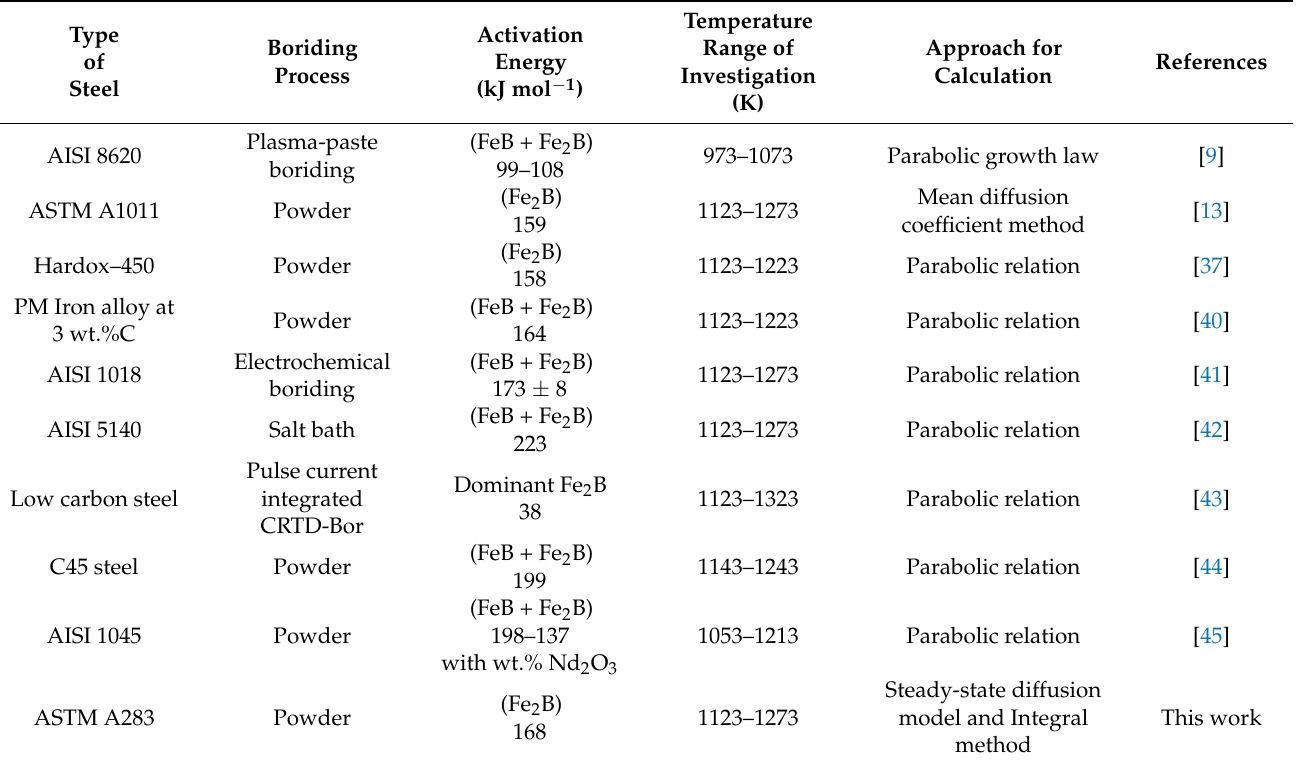
Table 2. Obtained boron activation energies in case of some treated